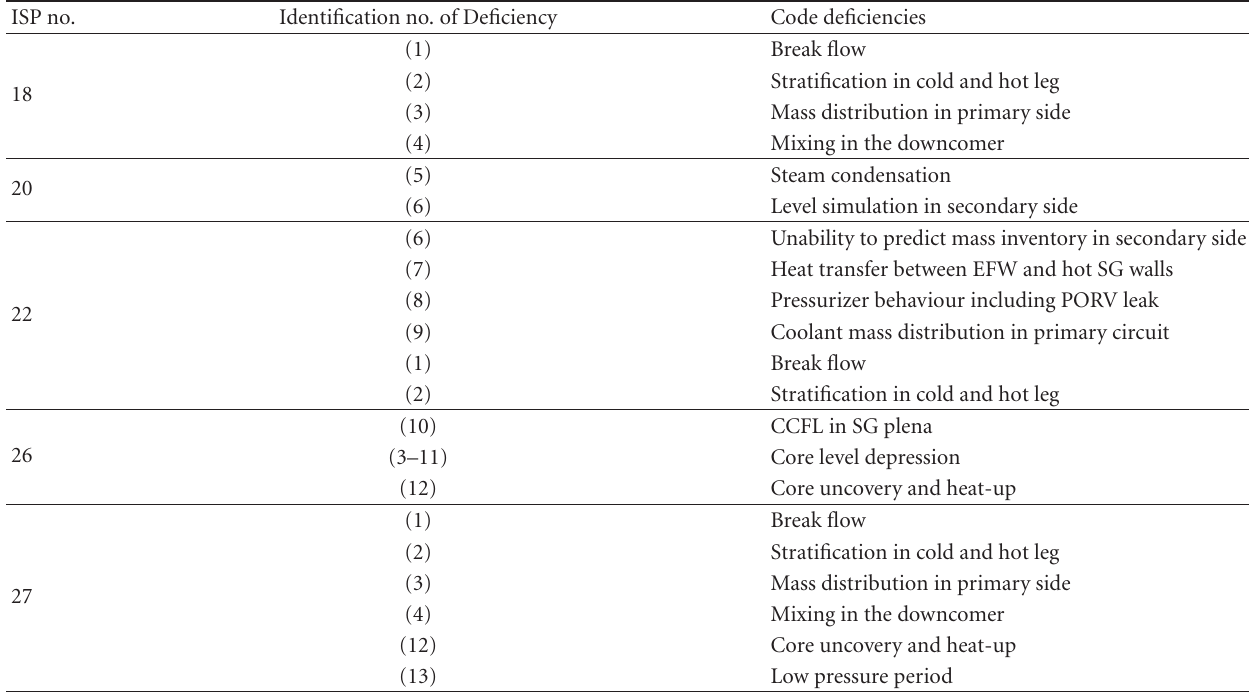
Table 9: General code deficiencies for the considered ISPs.